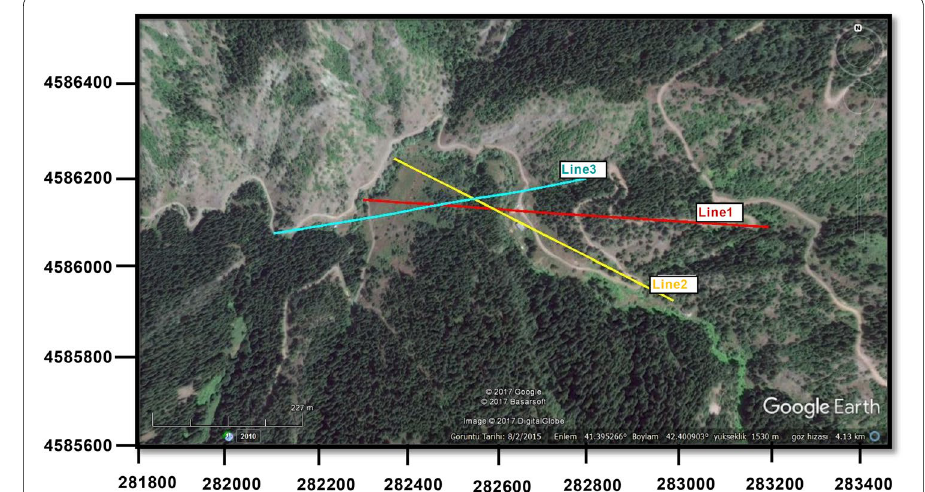
Fig. 2 Satellite image of 2D resistivity profiles in the study area